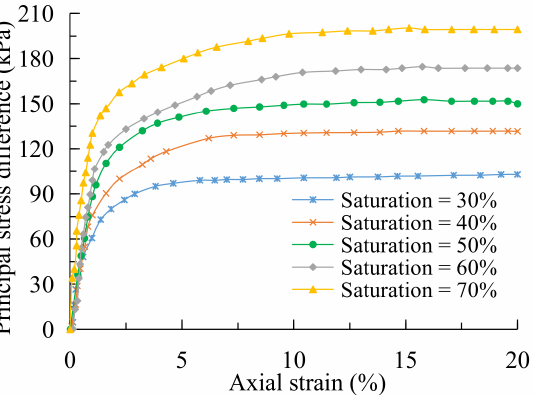
Figure 11. Stress–strain curve under various saturations ( ρ d = 1.6 t/m 3 , σ − µ a = 150